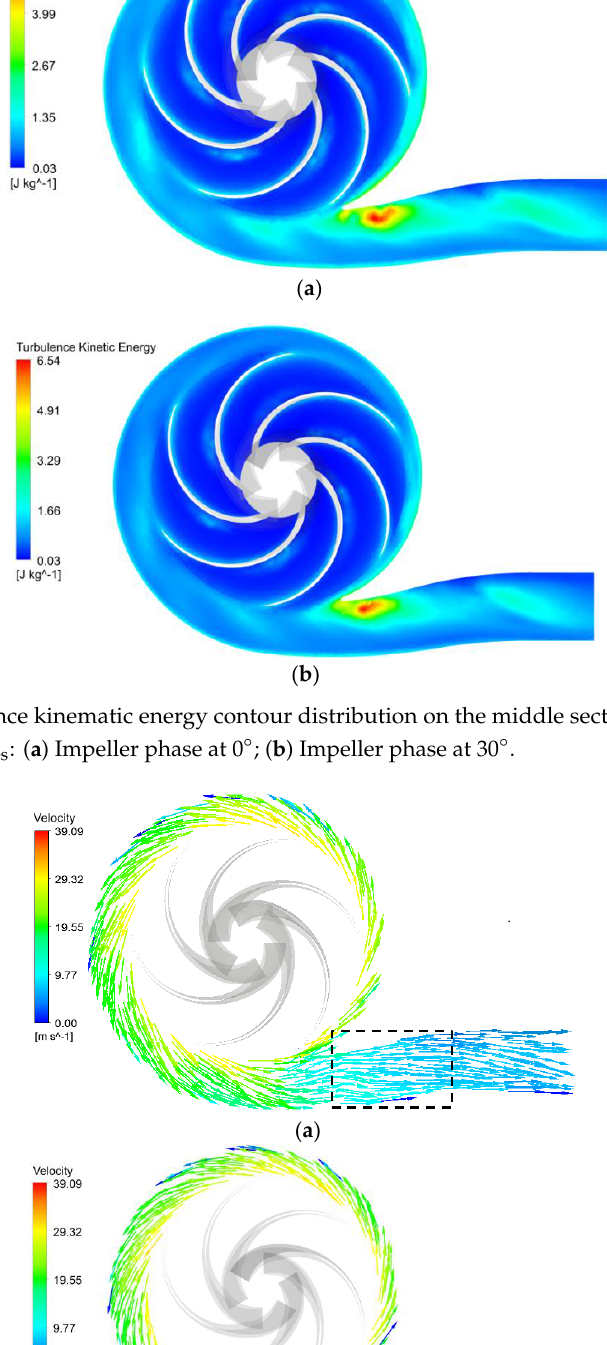
Figure 27. Turbulence kinematic energy contour distribution on the middle section of the discharge chamber under Q des : ( a ) Impeller phase at 0°; ( b ) Impeller phase at 30°.